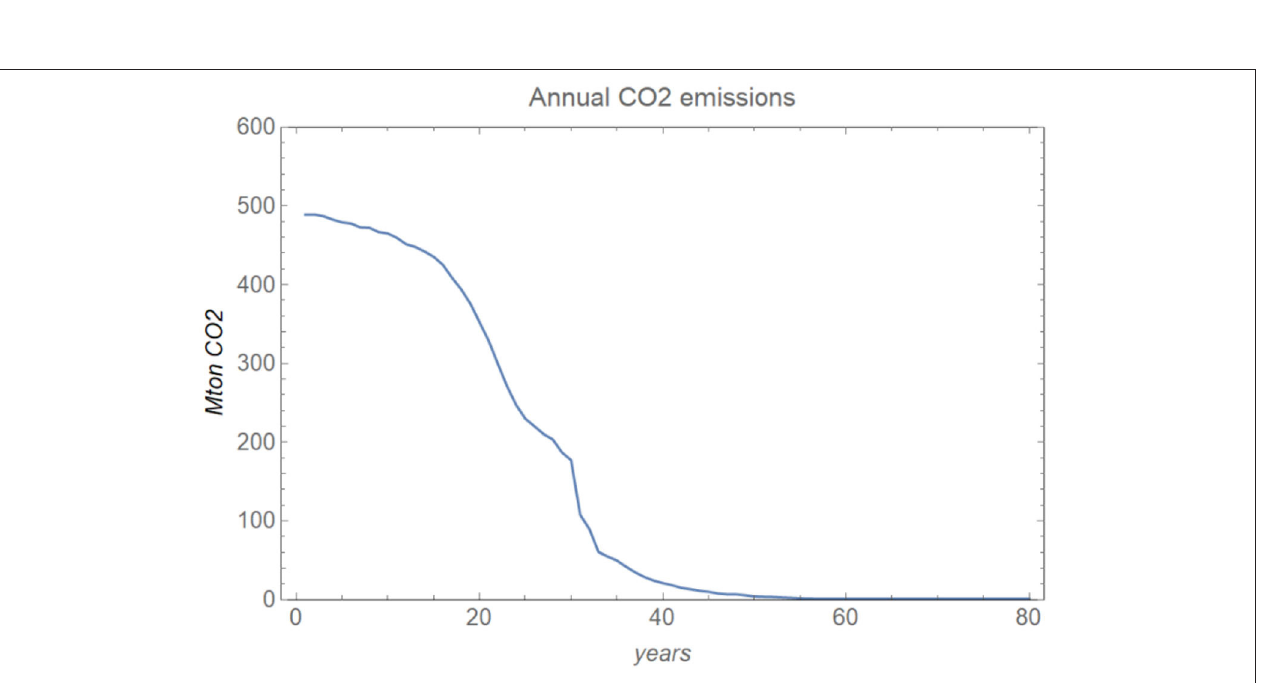
Frontiers in Climate |